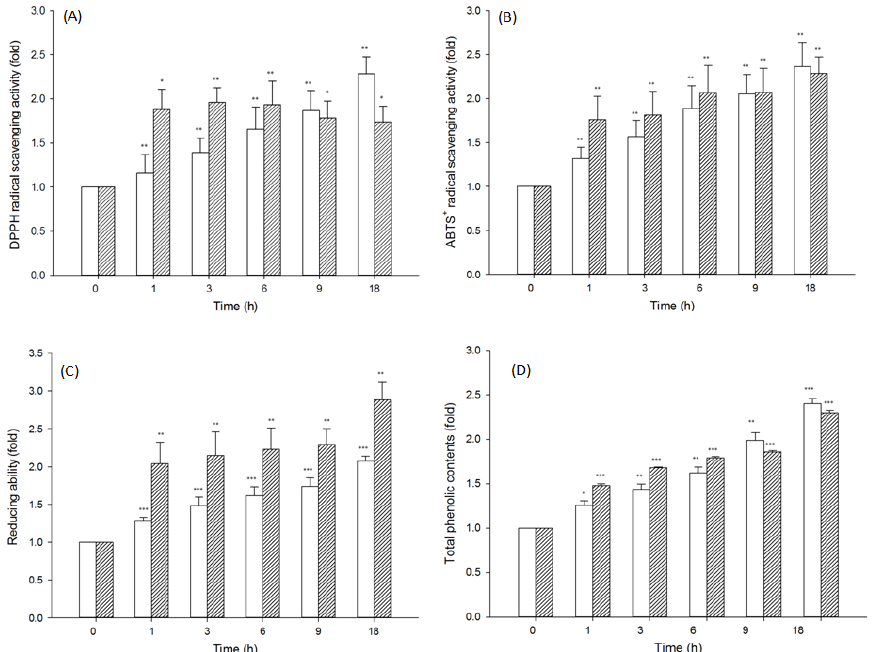
Figure 8. Antioxidant activity of edible medicinal Polyporaceae enzyme hydrolysate prepared using β -1,3-glucanase from Y. lipolytica transformant (pYLSC1- 13g ). ( A ) DPPH radical scavenging assay; ( B ) ABTS + radical scavenging activity; ( C ) reducing power assay; ( D ) total phenolic content assay. mean ± SE from triplicate experiments (Student’s t -test p values: * p < 0.05; ** p < 0.01; *** p <